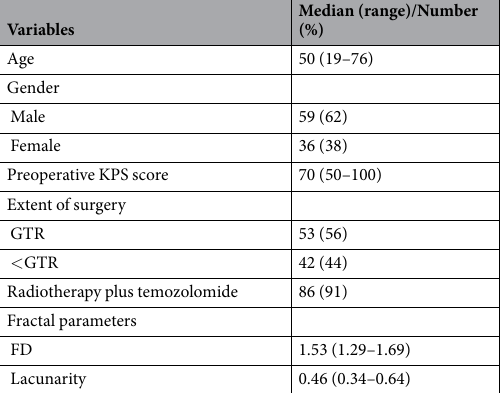
Table 1. Clinical characteristics of patients with GBM (n = 95). Abbreviations: KPS = Karnofsky performance status; GTR = gross total resection; FD = fractal